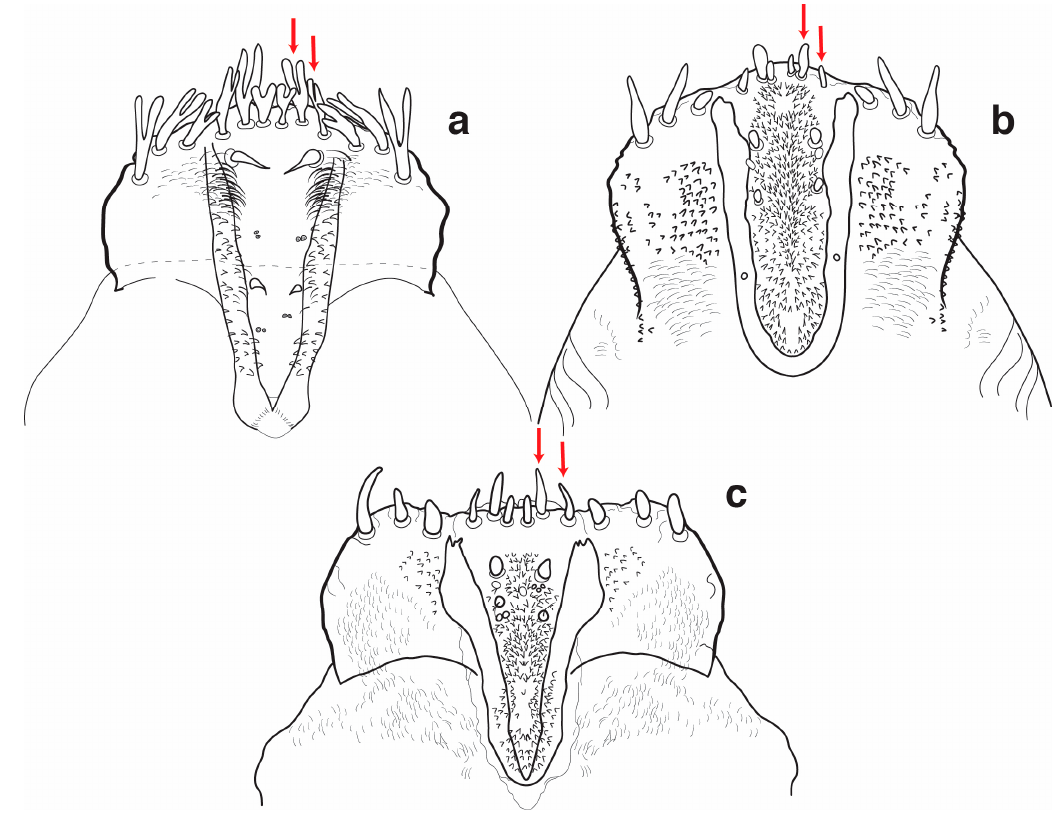
Figure 29. Epipharynx, larva: ( a ) Eucalandra ; ( b ) Phacecorynes ; and ( c ) Rhodobaenus . 16. Position of median epipharyngeal setae 3 (mes3) (Figure 30)